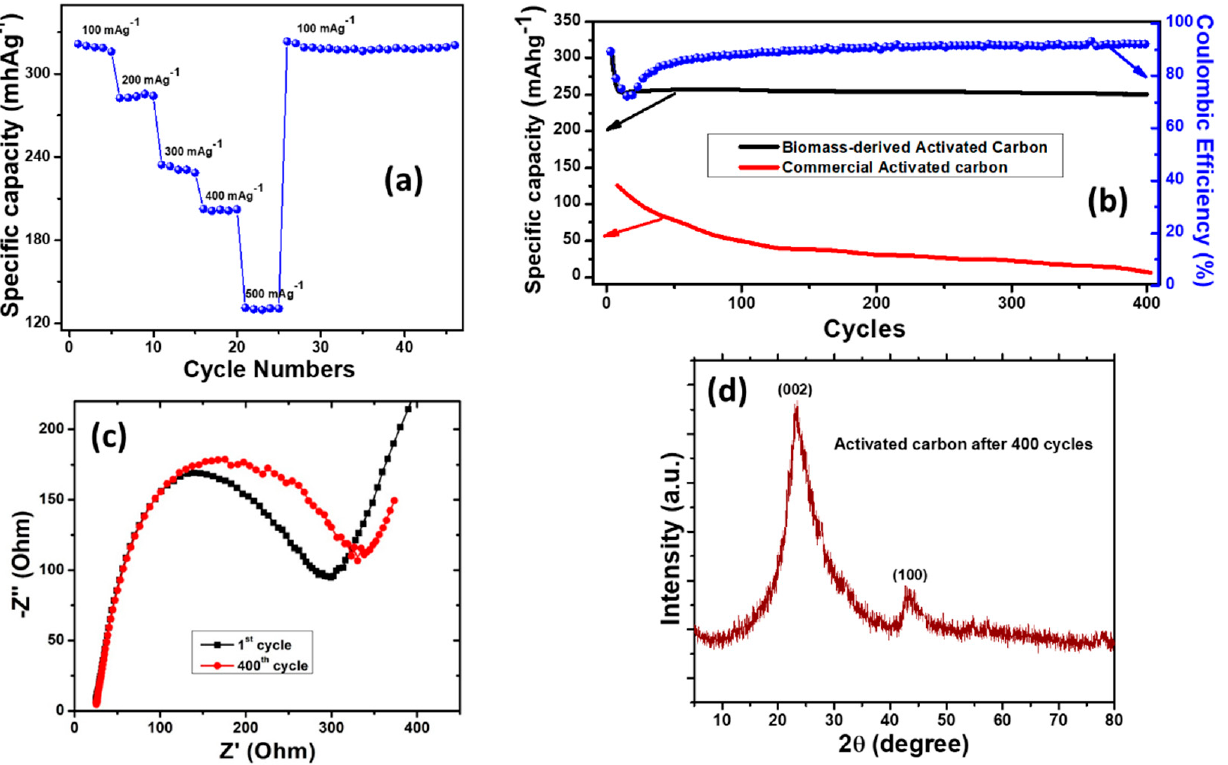
Figure 5. ( a ) Rate capability of activated carbon at various current densities. ( b ) Cyclic performance of the fabricated cell with the activated carbon anode and commercial activated carbon at a current density of 100 mAg − 1 . ( c ) EIS Nyquist plots of activated carbon electrode for the 1st cycle and 400th cycle. ( d ) XRD patterns of rice husk-derived activated carbon after 400 cycles of charge/discharge at a current density of 100 mAg − 1 .